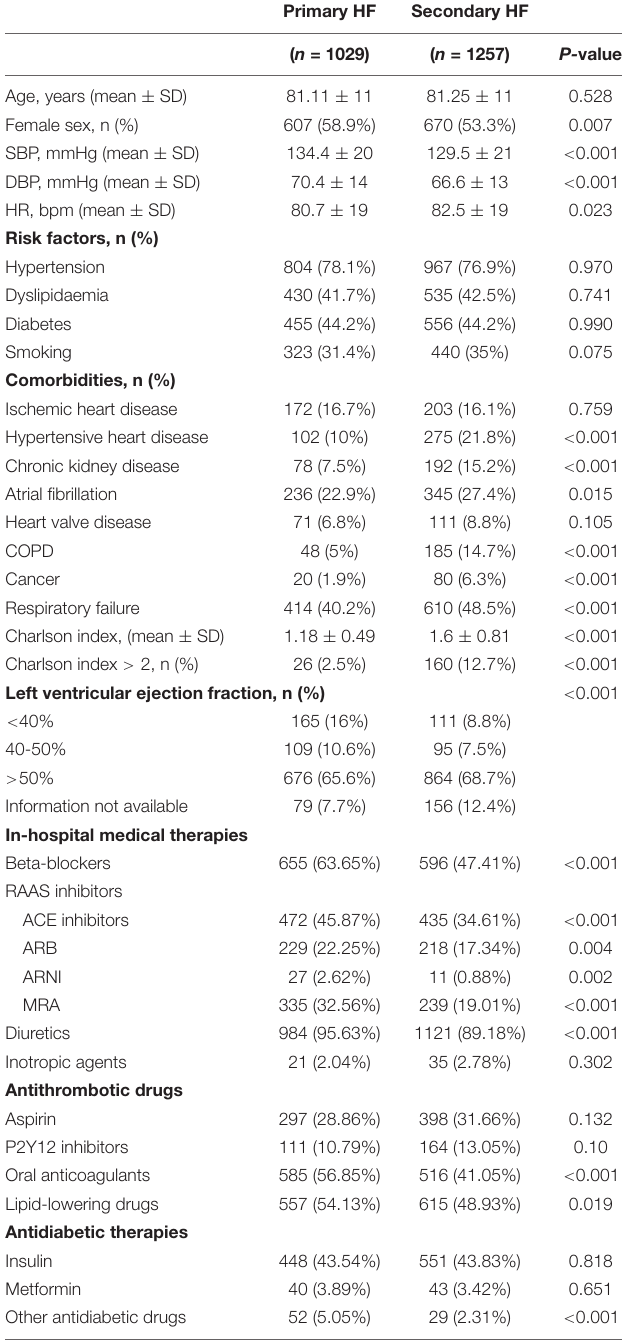
TABLE 1 | Baseline characteristics in hospitalized patients.